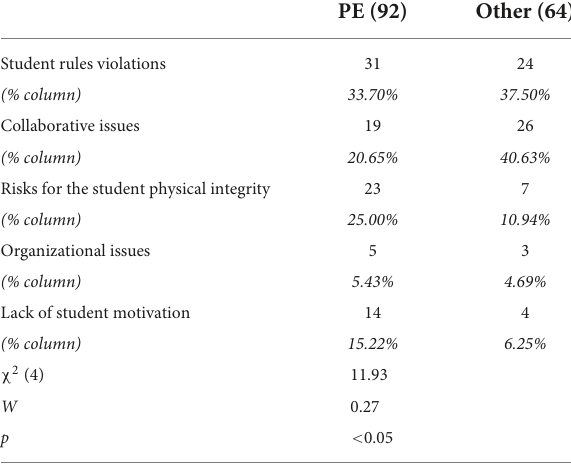
TABLE 2 Event class distribution of event 2 for physical education teachers (PE) vs. teachers of other subjects